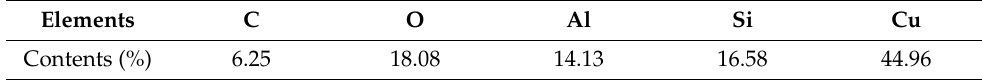
Table 4. Elements and